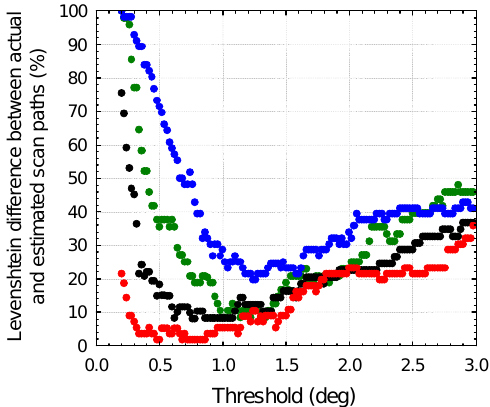
Figure 8: Levenshtein distance (LD) between benchmark and estimated scan paths against threshold for four participant recordings after application of the Radius metric for fixation